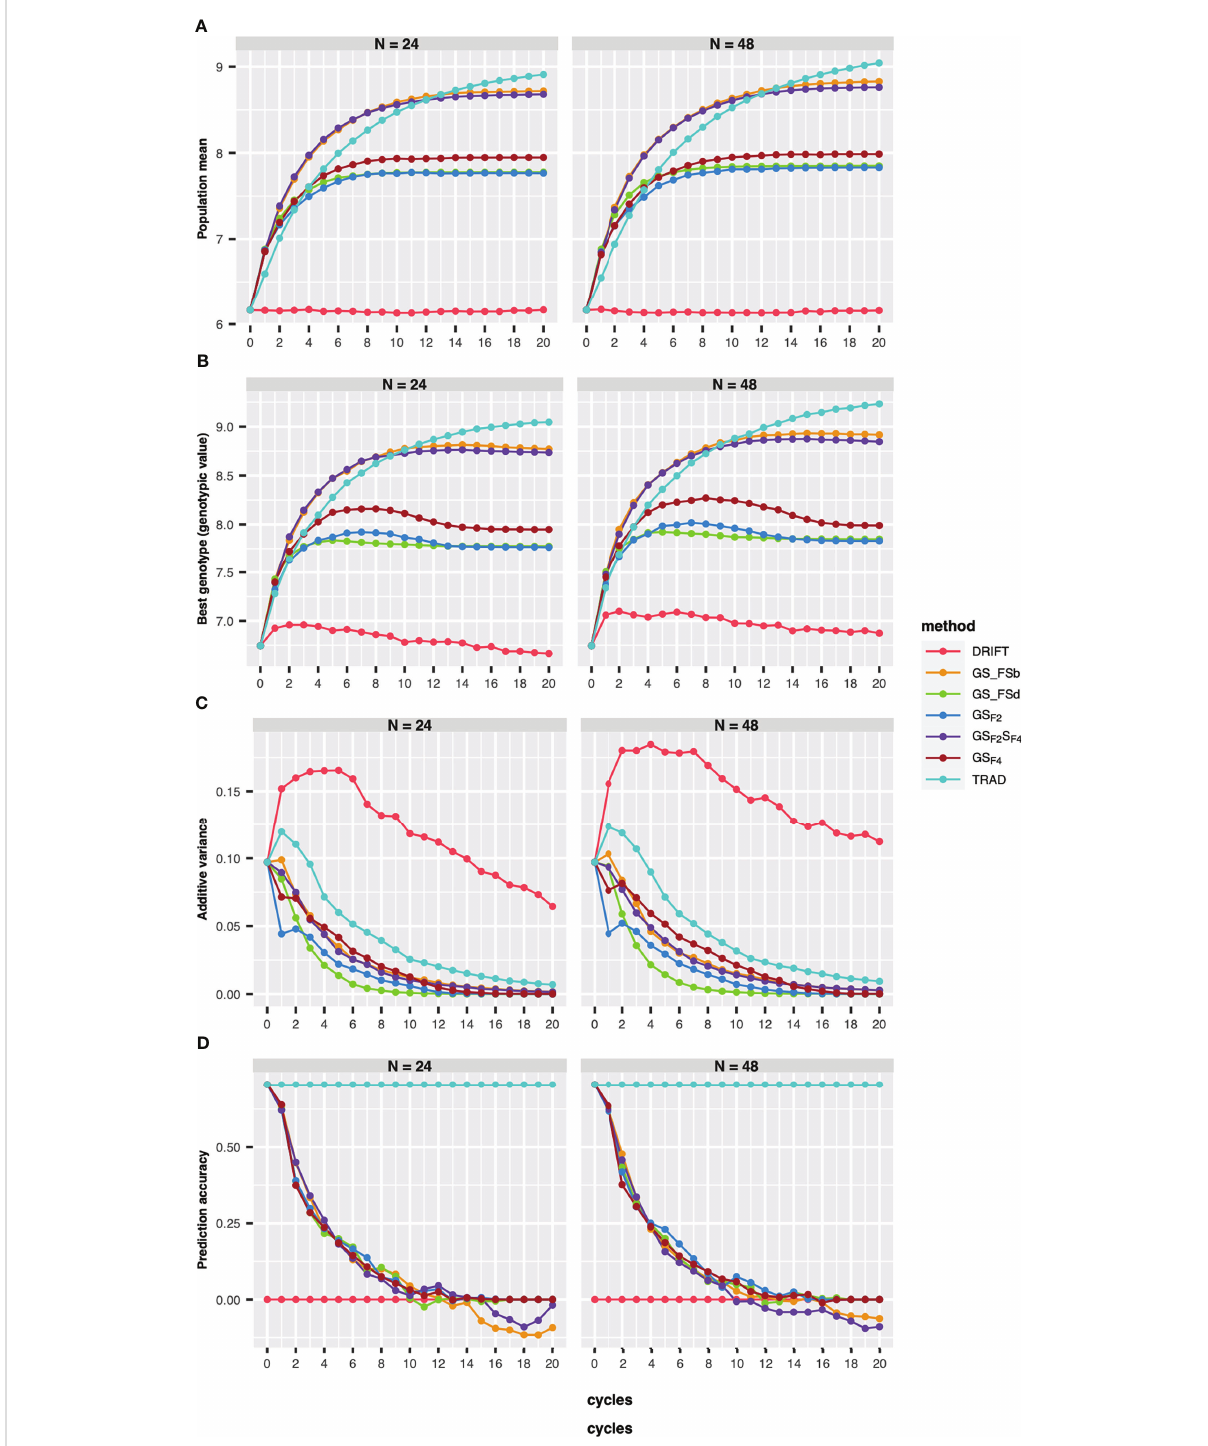
FIGURE 2 Population mean (A) , the best genotype (B) , additive variance (C) , and prediction accuracy of selection (D) over 20 recurrent cycles using two sizes of parental lines (N=24 and N=48). Each colored line represents a breeding scheme. Trad: traditional phenotypic selection; Drift: random selection; GS F2 : genomic selection performed in F2 stage; GS F2 S F4 : genomic selection performed in F2 stage and phenotypic selection performed in F4 stage; GS F4 : genomic selection performed in F4 stage; GS_FSb: genomic selection performed on F2 stage to select the two best individuals based on genomic estimated breeding values and crossed them to make a new recombination event; GS_FSd: genomic selection performed on F2 stage to select the two most divergent individuals and crossed them to make a new recombination